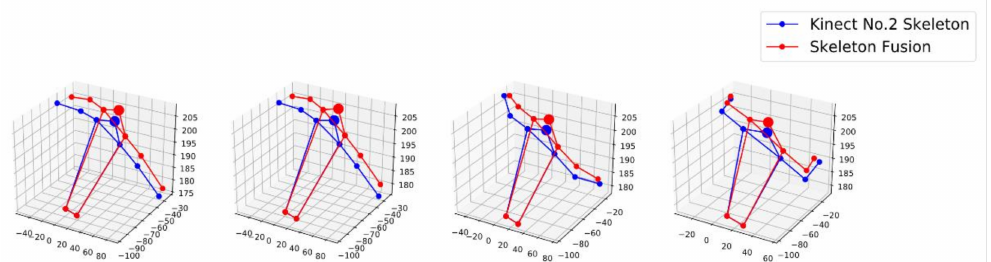
Figure 5. 3D skeleton poses obtained by Kinect 2 and skeleton fusion.